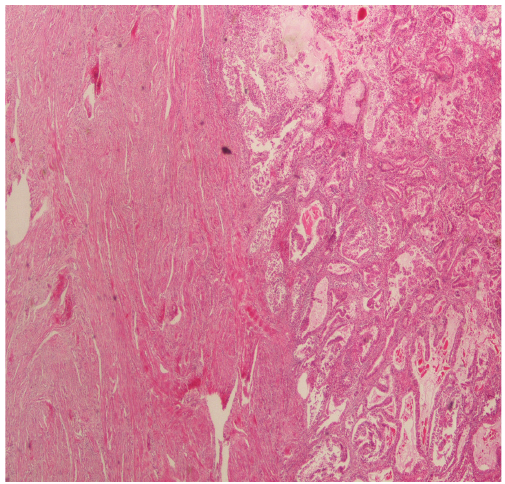
Figure 2: Microphotograph from a section of the ovarian tumor (endometrioid type carcinoma) (H&E ×